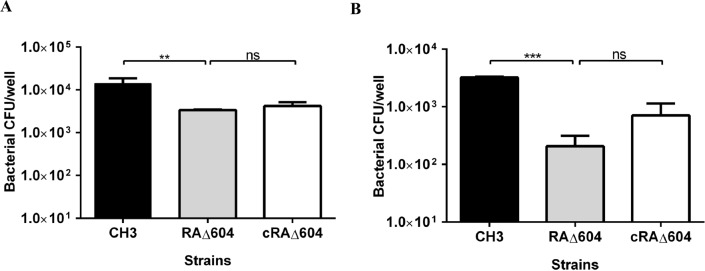
Bacterial adherence and invasion assays.(A) Adherence assay. (B) Invasion assay. Each point represents the mean ± standard deviation. Both adherence and invasion capacities of the mutant strain RAΔ604 were decreased, as compared with those of R. anatipestifer WT strain CH3 (***, p < 0.01; **, p < 0.05). The complementation strain cRAΔ604 partially recovered adherence and invasion capacities (ns, p > 0.05).